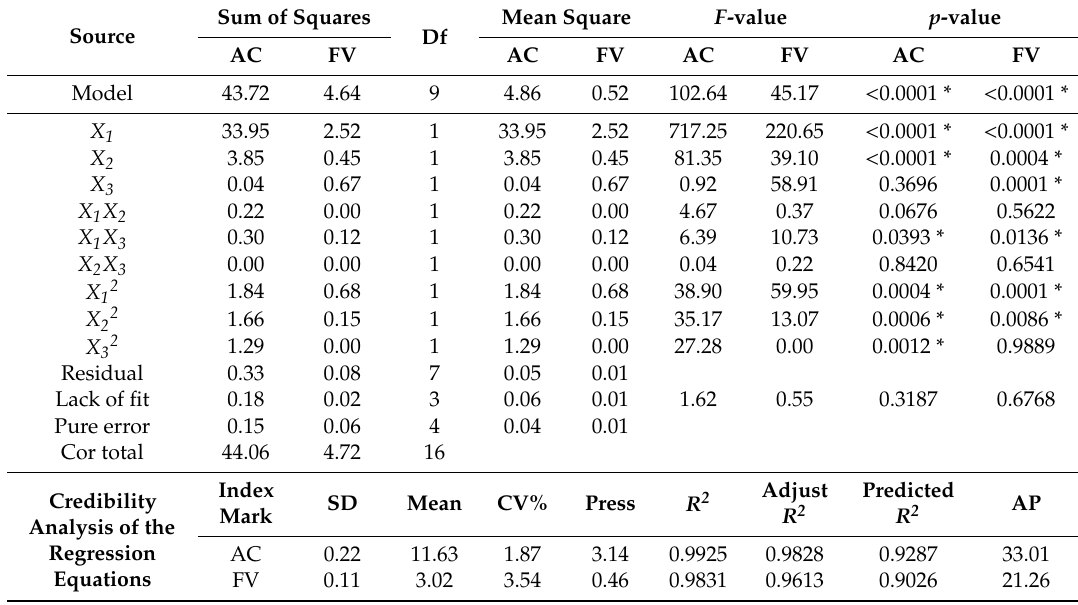
Table 2. The estimated regression coe ffi cients and analysis of variance (ANOVA) for the quadratic models of anthocyanins and flavonols determined from BBD a